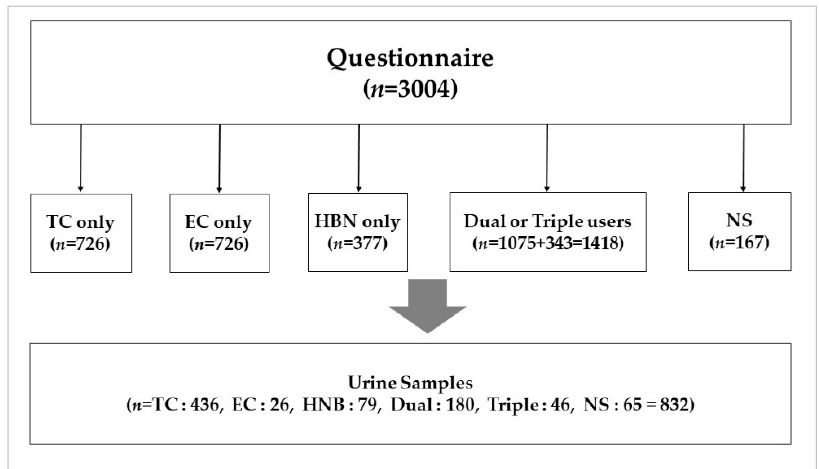
Figure 1. Study framework for smoking behavior including nicotine dependence level and biomarker levels among study participants (among nonsmokers or single-type cigarette users, those who provided a completed questionnaire and urine samples were 63 for NS and 403, 24, and 76 for TC, EC, and HNBC, respectively.).